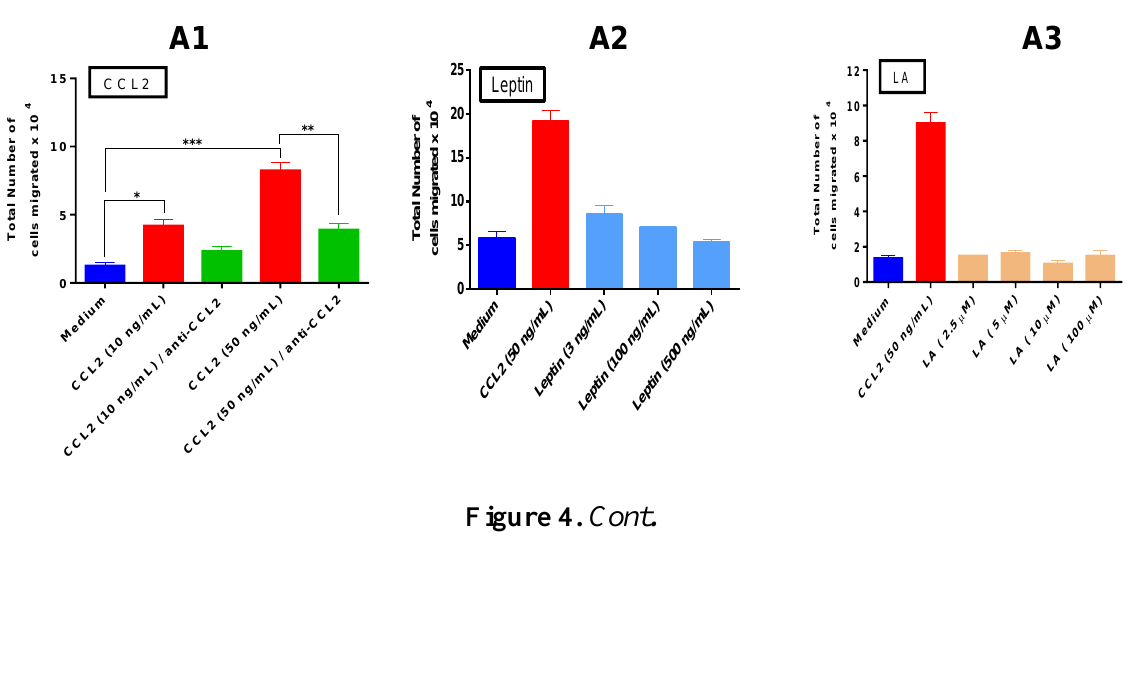
Figure 3. Co-culture of adipocytes, tumor cells and macrophages reveals the highest production of CCL2 (MCP-1). 48 h supernatants from in vitro differentiated ( A ) and ex vivo isolated ( B ) adipocytes co-cultured with macrophages and tumor cells were analyzed for CCL2 production using ELISA. Data are representative of one of three independent experiments showing similar results; each sample was tested in duplicates. One-way ANOVA analysis showed differences among all the samples in both figures (**** p < 0.0001), and TMCT comparisons are depicted in the